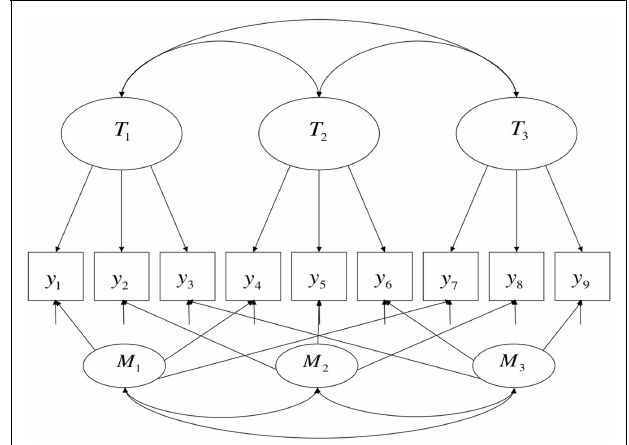
FIGURE 1 |A Correlated-Trait, Correlated-Method (CTCM)